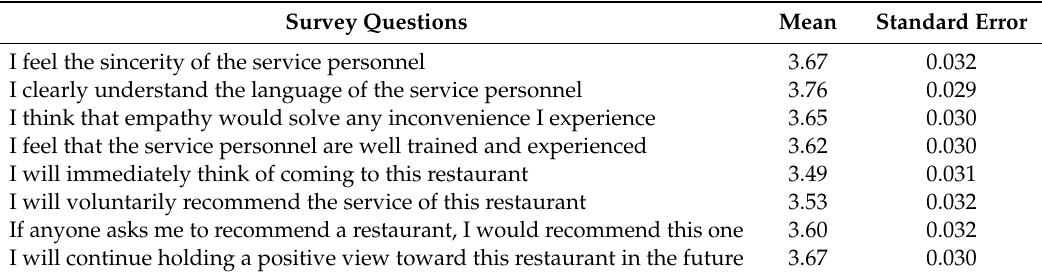
Table 3. Satisfaction with the waiting service of the